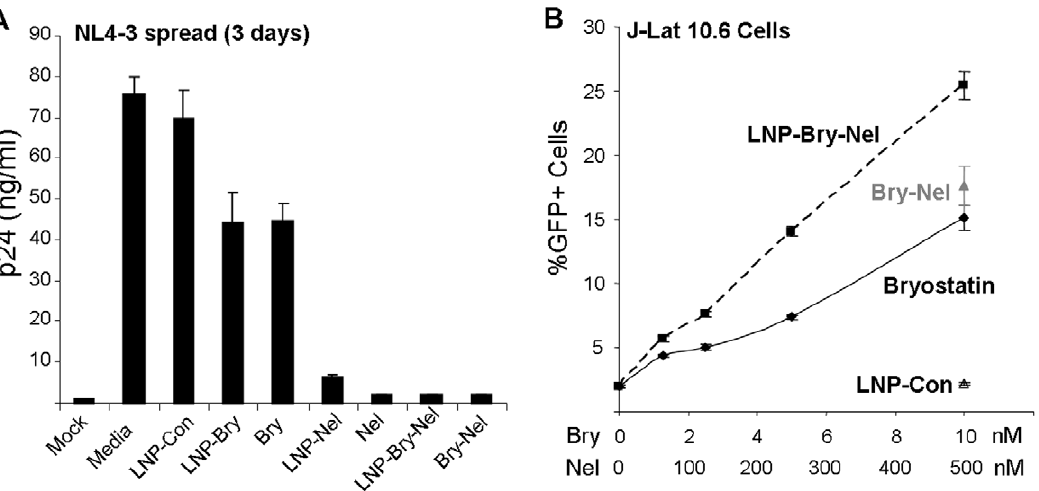
Figure 3. Simultaneous incorporation of the protease inhibitor nelfinavir (Nel) and bryostatin-2 (Bry) into the lipid nanoparticles (LNP-Bry-Nel) can both activate latent virus expression and inhibit viral spread. (A) CEM cells were infected with HIV NL4-3 and the cells were incubated for 3 days in the presence of various drug combinations including LNP-Bry-Nel. Viral p24 protein in the culture supernatant was measured by ELISA. (B) LNP-Bry-Nel was further tested for its ability to activate latent virus in J-Lat 10.6 cells as measured by induction of GFP expression. Error bars indicate the standard deviation of triplicate data points and are representative of at least 2 experiments. Media represents untreated infected cultures and LNP-con represents non-drug loaded